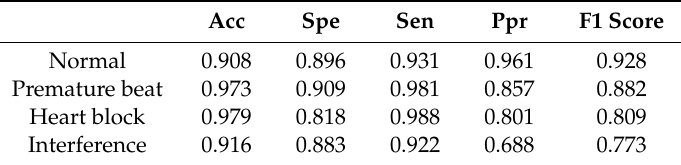
Table 2. Performance of the proposed model for ECG